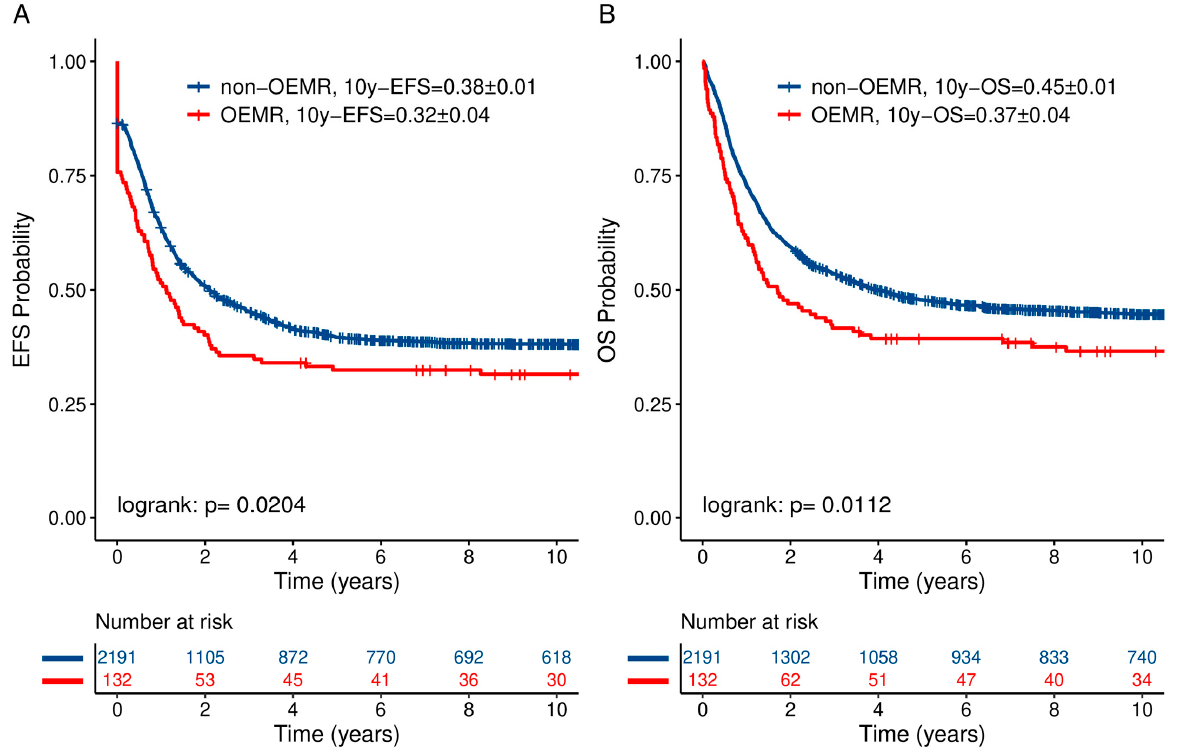
Figure 1. Ten-year pEFS (A) and pOS (B) of relapsed ALL patients differ significantly in OEMR vs. non-OEMR patients. The graphs have been calculated based on Kaplan–Meier analysis. p < 0.05. Table 5. pEFS and pOS in non-OEMR, all OEMR and OEMR